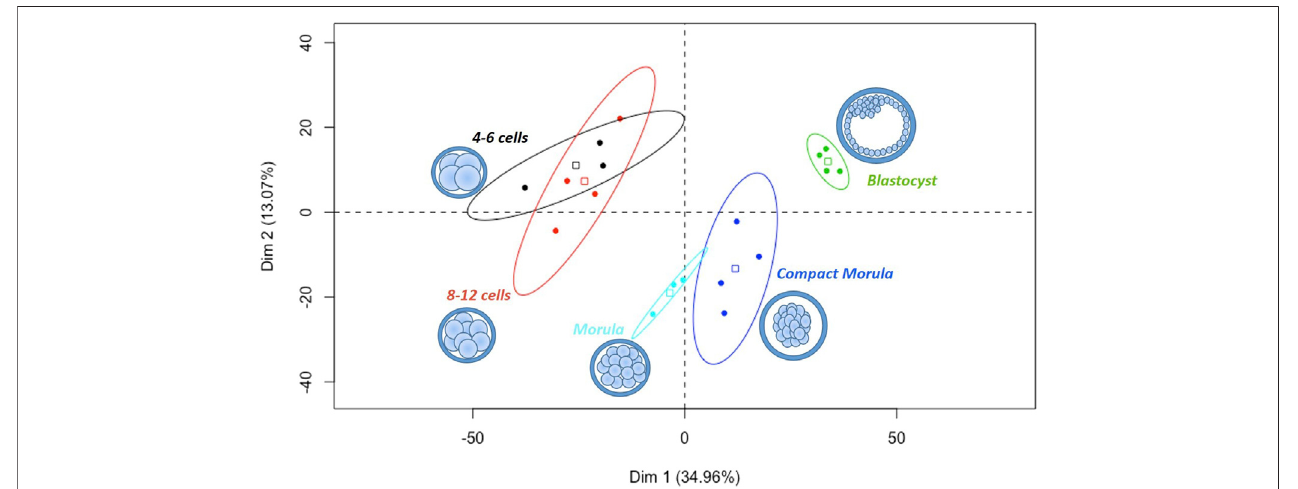
FIGURE 2 | Principal component analysis of all in vivo embryos pools from the 4 – 6 cell to blastocyst stages. All proteins quanti fi ed with min 2 NWS in at least one stage were considered. Scatter plots represent the position of each pool of embryos along the fi rst two dimensions of PCA. The variability between pools was mainly explained by their stage of development on the fi rst horizontal dimension (Dim 1, 35% of variance). The square in each ellipse represents the mean of data for a given stage and colored ellipses represent the 95% con fi dence intervals.